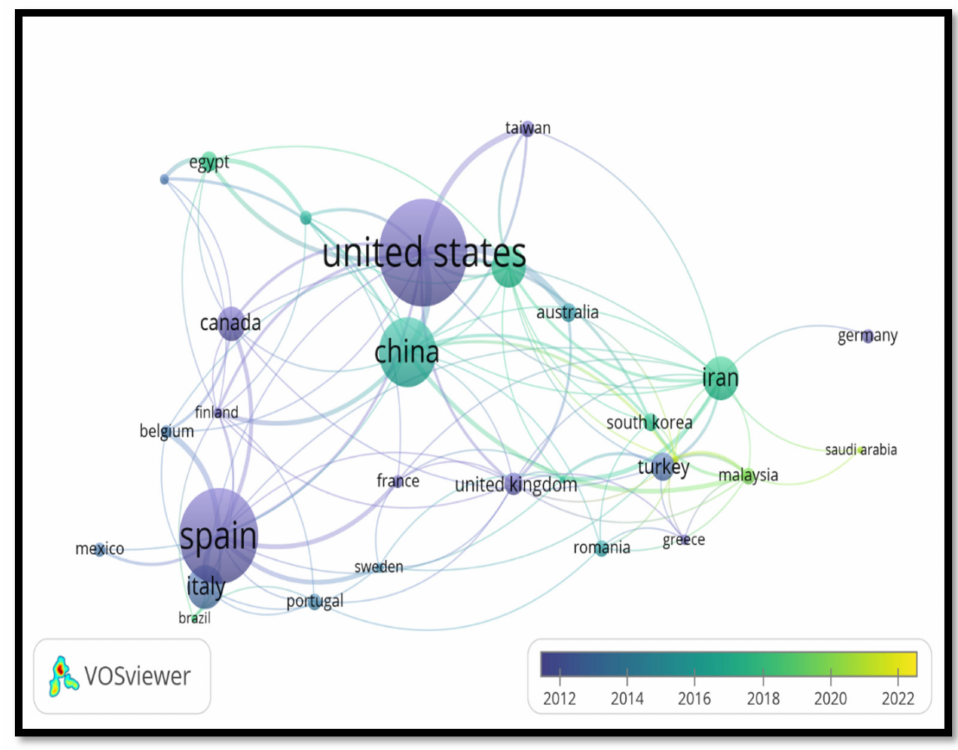
Figure 15. Network of relationships between countries with research teams. Source Data from the Scopus between 2012 and 2022. VOSviewer network visualization map of the top producing countries for “artificial intelligence models for wastewater treatment” research.